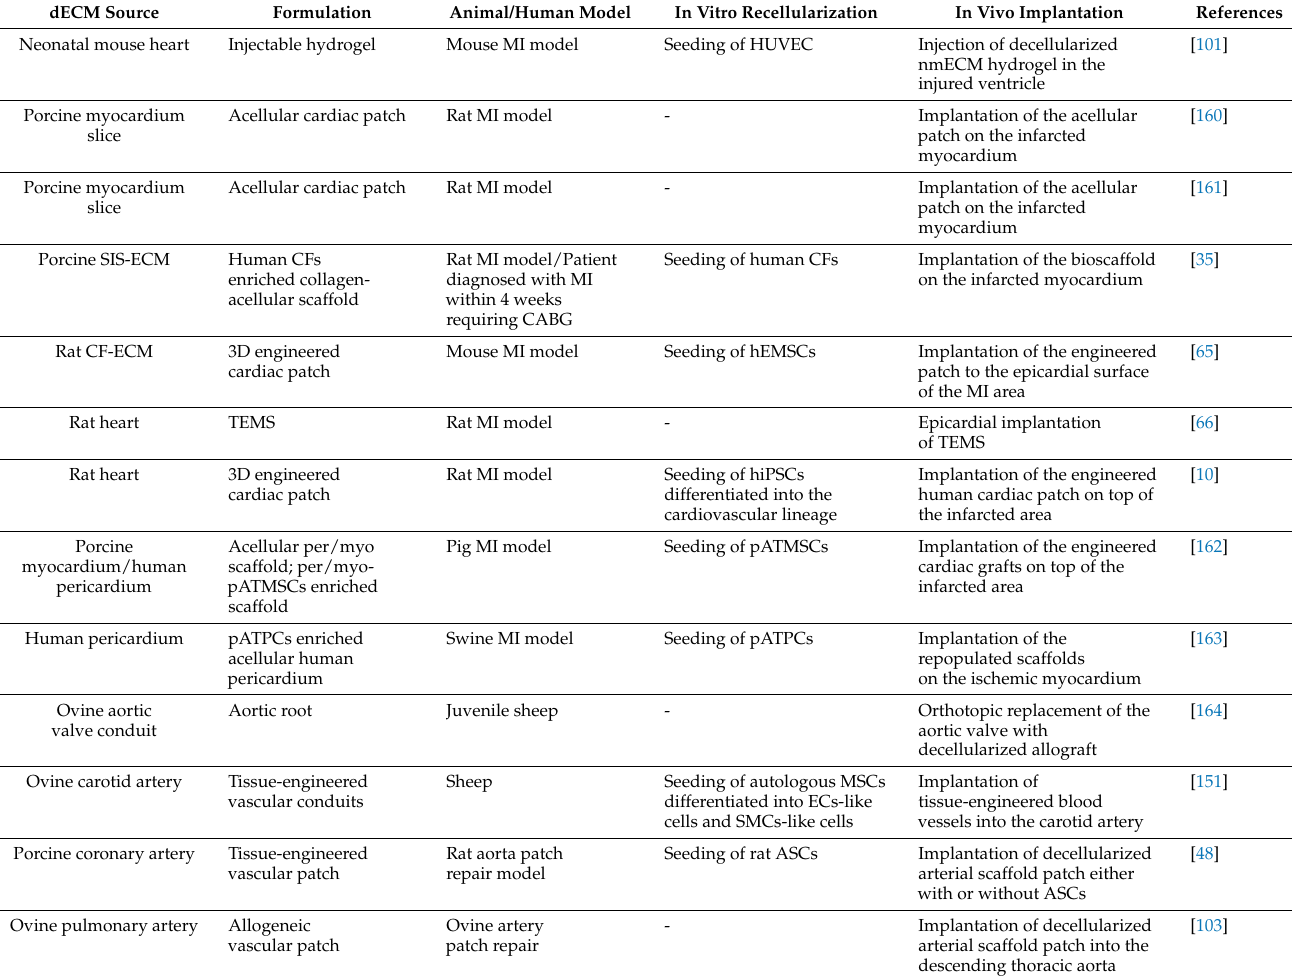
Table 5. Application of cardiac dECM in regenerative